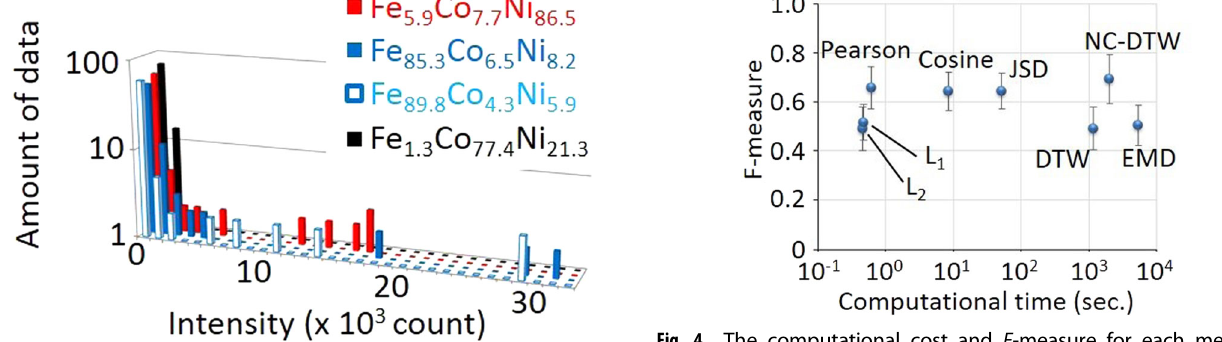
Fig. 5, use of the NC-DTW measure provides the greatest accuracy, while still at a signi fi cant computational cost (2003.41 s). Also the clustering result shown in Fig. 2i is quite similar to the correct composition-phase map shown in Figure 2a. The light blue , red , green and blue regions in Fig. 2i represent bcc, hcp, fcc and bcc + fcc phases, respectively. To gain further insight into the relative performance of the various measures, a qualitative analysis using MMDS was performed.